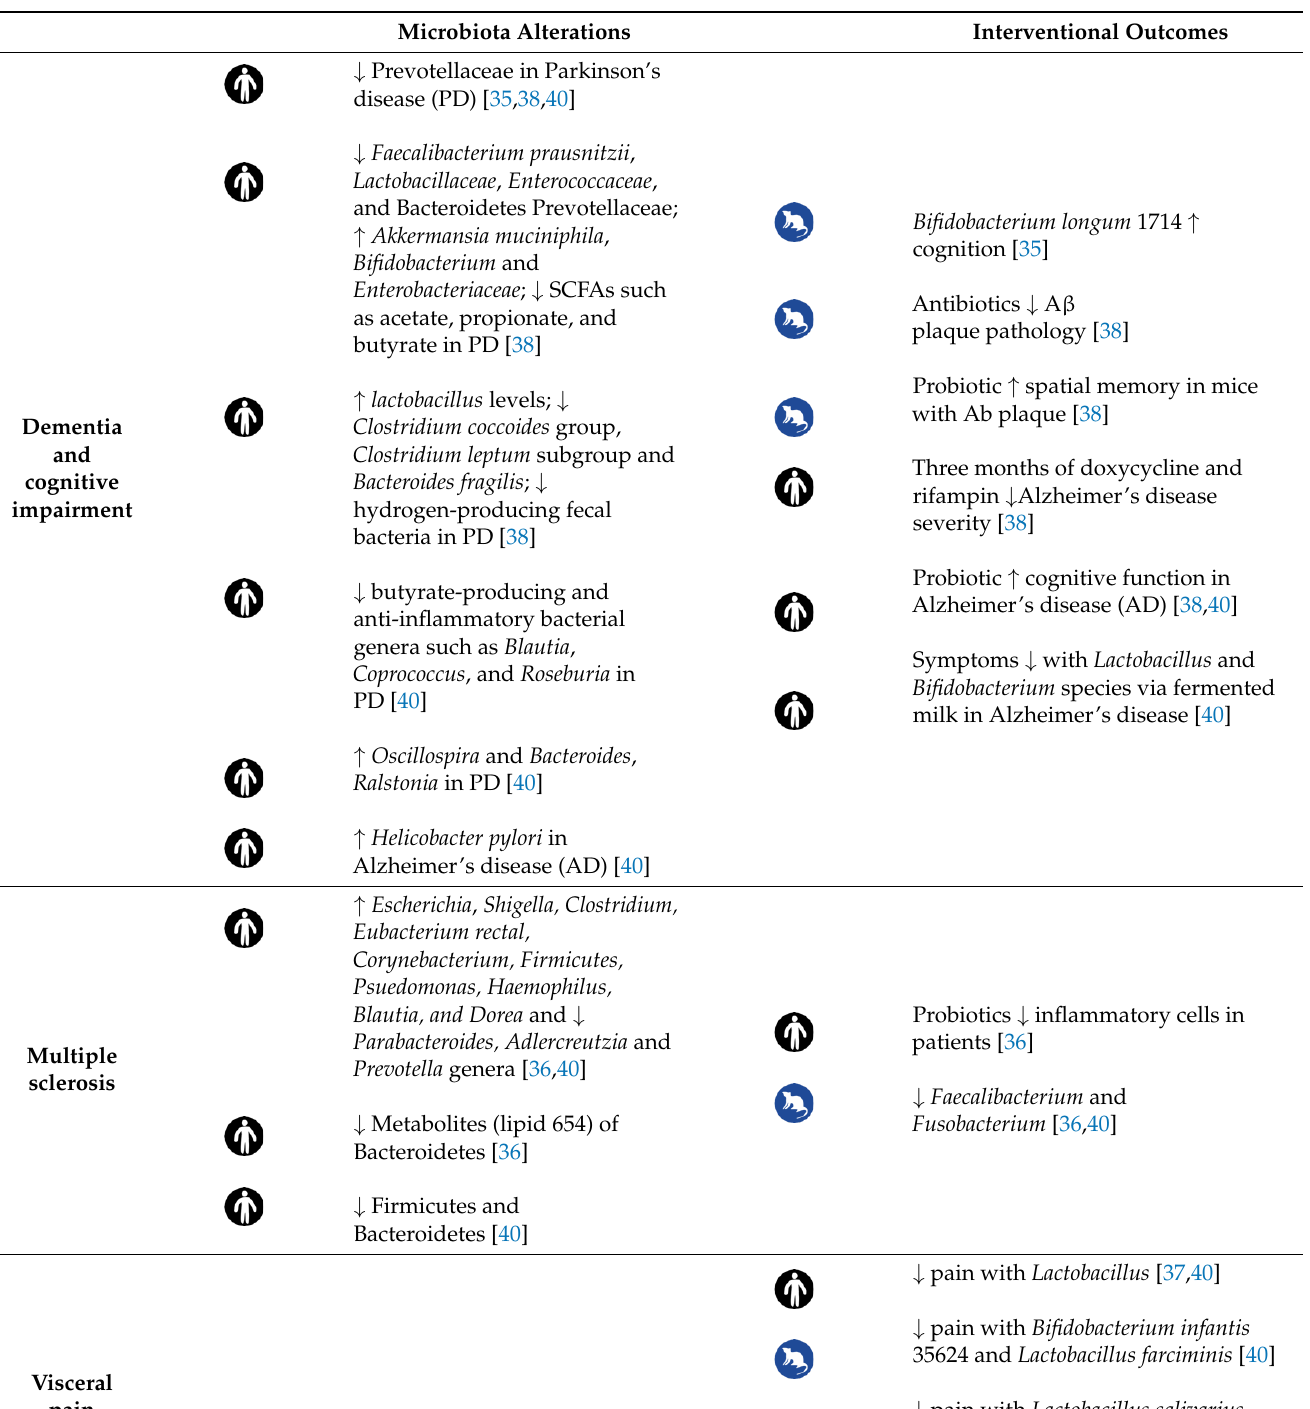
Table 1. Microbiota -based interventions and their effect on the various neuropsychiatric disorders.